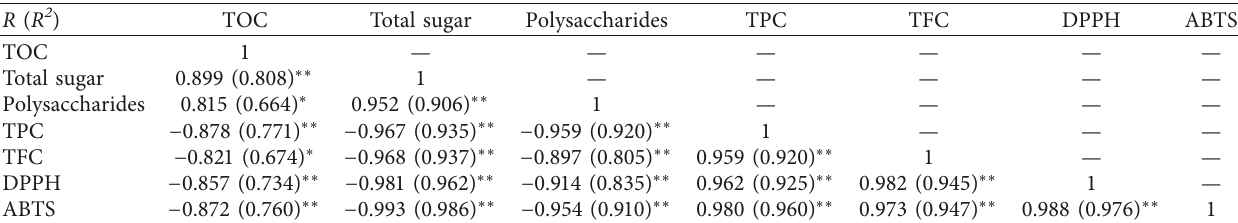
Table 2: Correlation coefficients between constituents and antioxidant activities of okara extracts by SWE. R ( R 2 ) TOC Total sugar Polysaccharides TPC TFC DPPH ABTS